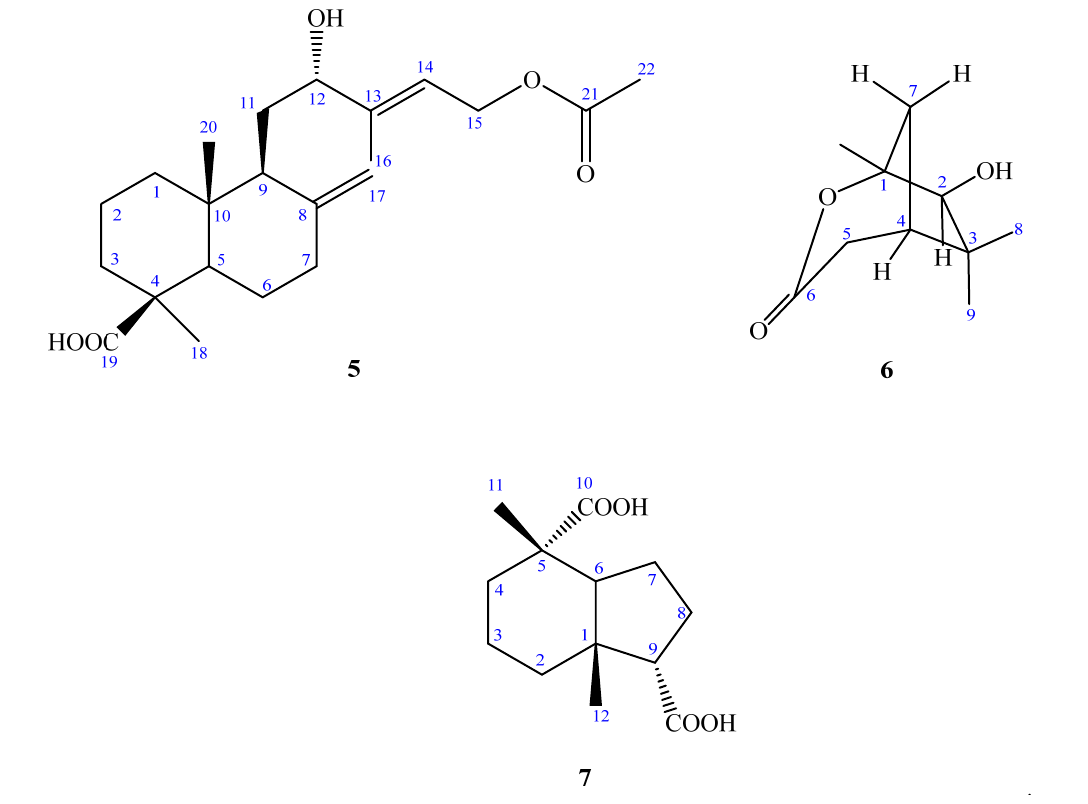
Figure 1. Compounds 1–7 , isolated from Chamaecyparis obtusa var. formosana